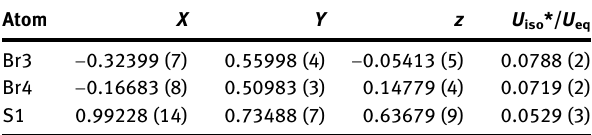
Table  : Fractional atomic coordinates and isotropic or equivalent isotropic displacement parameters (Å 